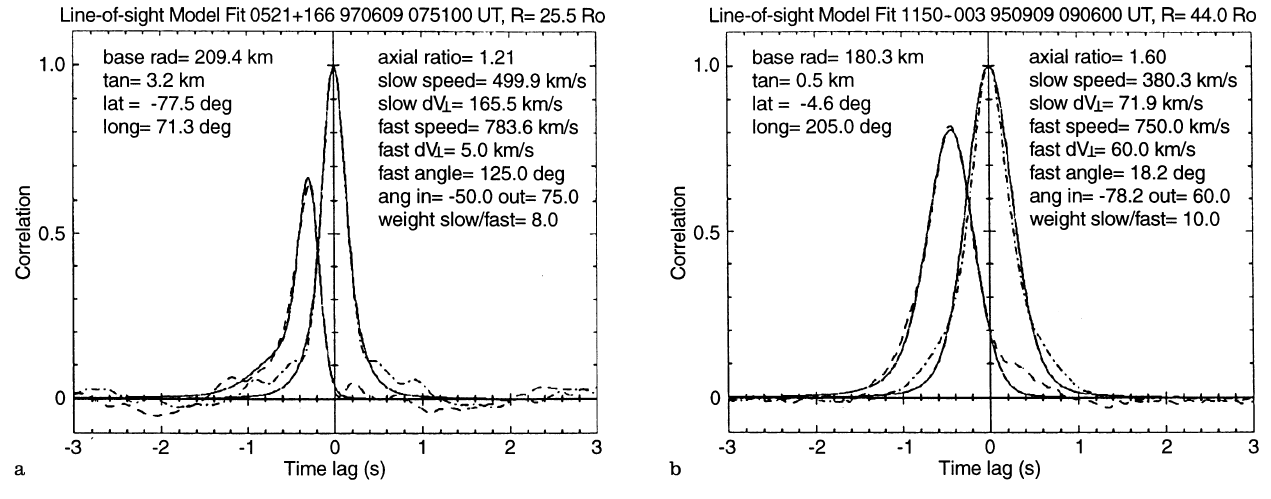
weak scattering model. The observation in dominated by fast flow. b Auto- and cross-correlation functions for the observation of 1150- 003 on 9 September 1995. The observation is dominated by slow flow